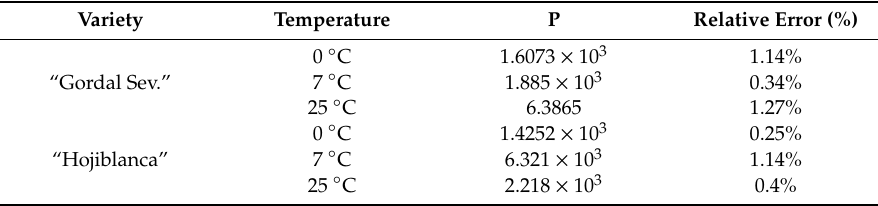
Table 3. Goodness of fit for processed olives according to variety and